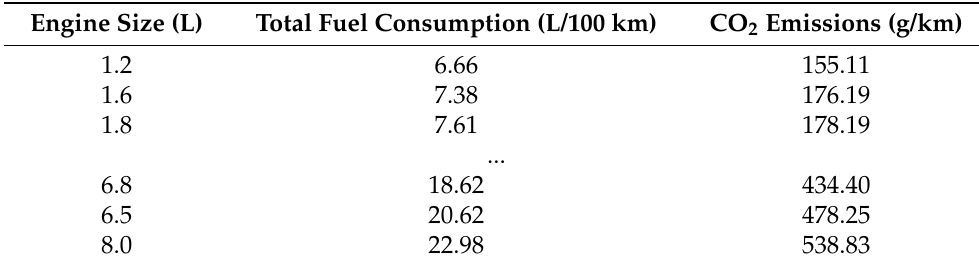
Table 5. CO 2 emissions (g/km) and total fuel consumption (L/100 km) of each engine size.